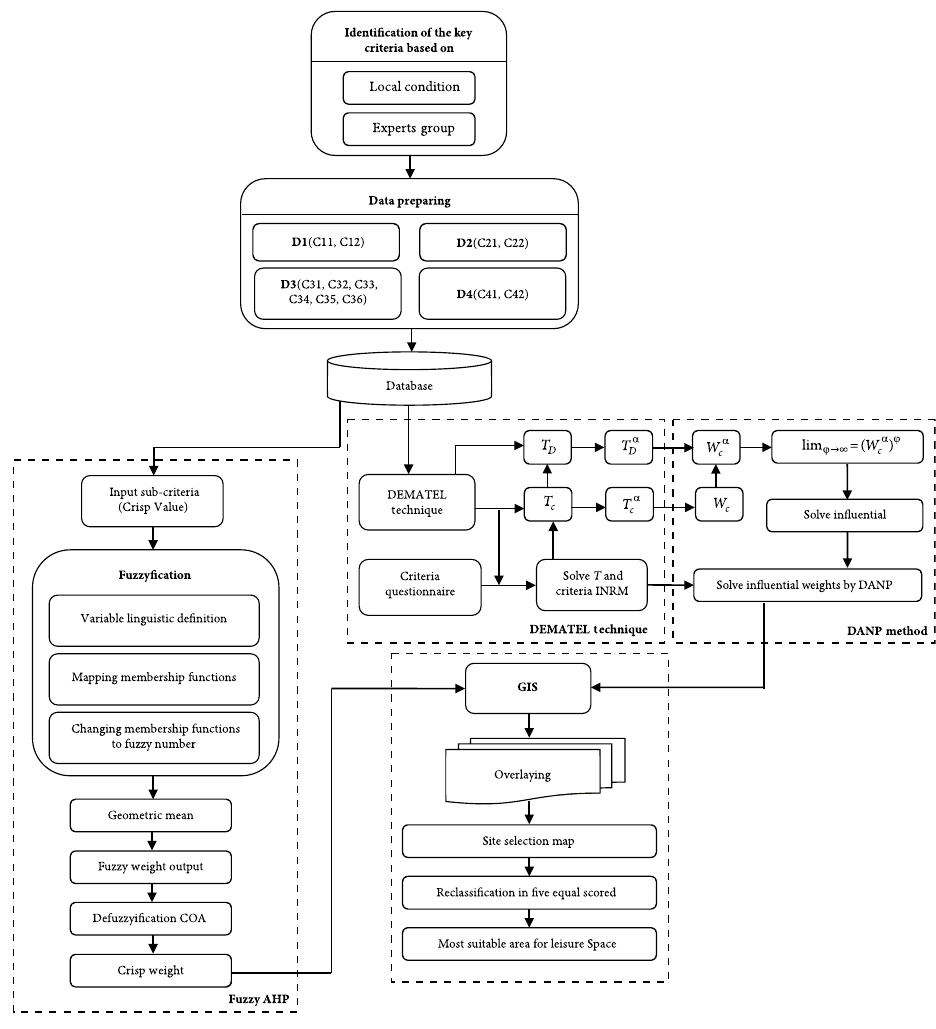
Fig. 1. Integrated approach of SZCD Table 2. Trapezoidal fuzzy numbers of linguistic variables Trapezoidal Fuzzy Numbers